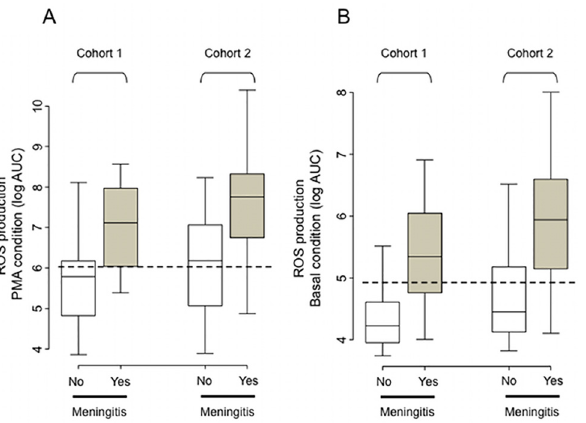
doi:10.1371/journal.pone.0128286.g001